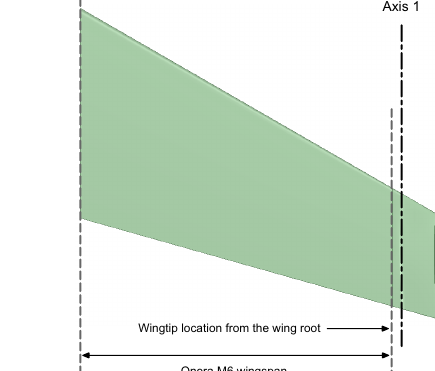
Figure 7. Winglet cant angle definition ( left image). The winglet extension is bent upwards about the axis 1 ( right image). This axis is located 40 mm away from the wingtip. For all cases studied, the curvature radius is no more than 30